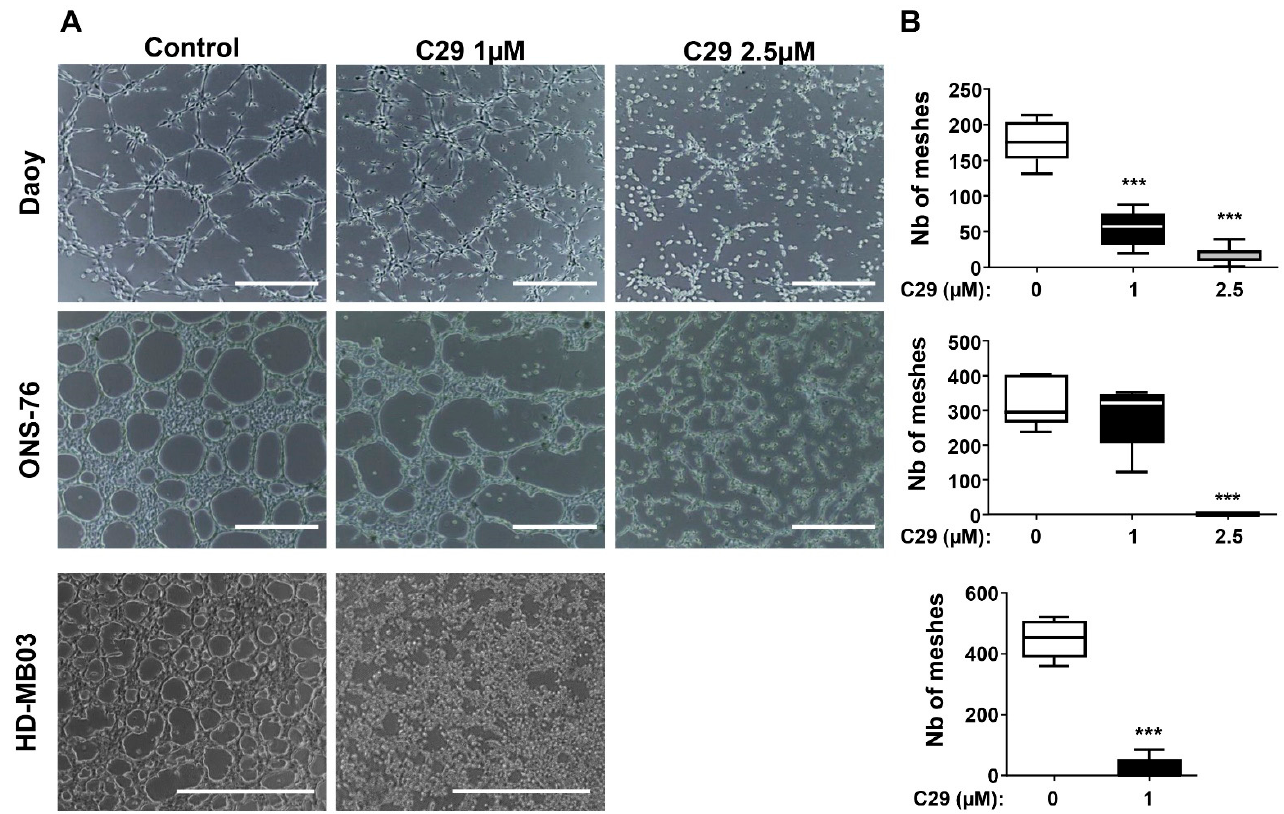
Figure 6. C29 inhibits the formation of pseudo vessel structures . ( A ) Formation of pseudo-vessels by Daoy cells, ONS-76, and HD-MB03 cultured on Matrigel and treated with Control (DMSO) or C29 (1 or 2.5 µM); n = 3. ( B ) Number of meshes (geometric units of the net formed by the cells on the matrigel surface) were counted with ImageJ. Statistics were performed using Student t -test for only 2 comparisons or ANOVA test for multiple comparisons. *** p < 0.001, scale = 500 µm.